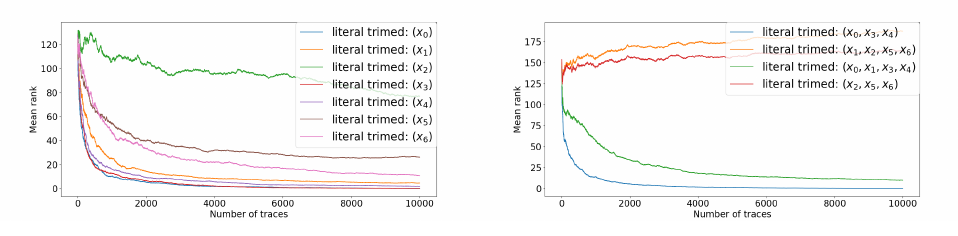
Figure 12: Guessing entropy for TTSCA big on ASCADv1_f for the step